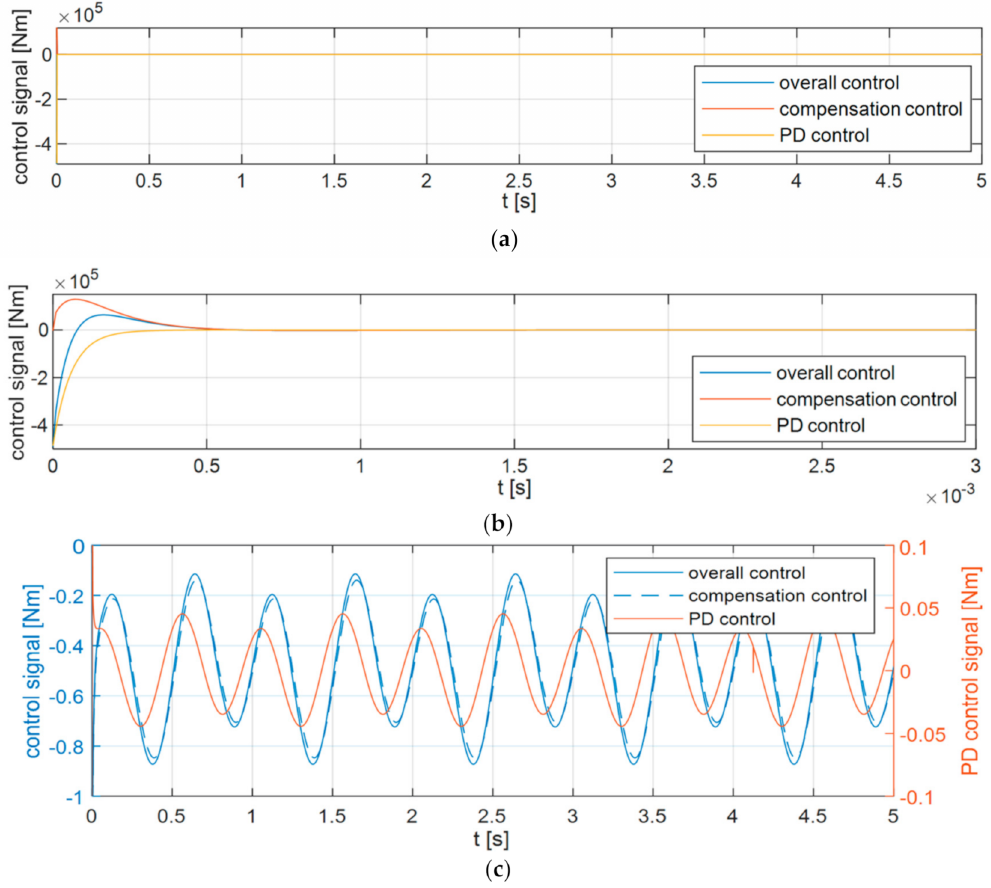
Figure 10. Control signals: ( a ) overall control system and control signal components; ( b ) control during the initial phase of gait; ( c ) control graph with customized